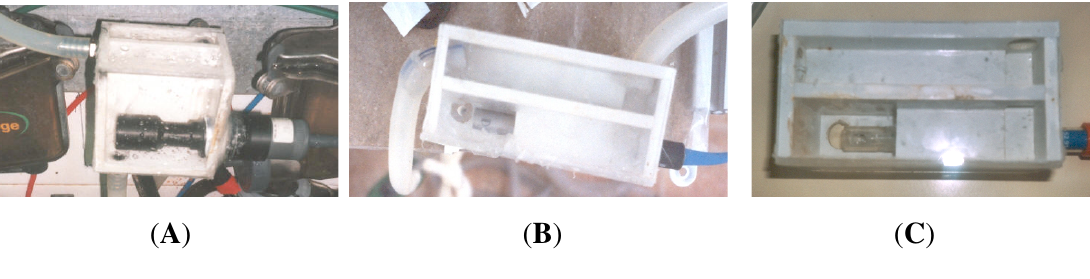
Figure 8. Hand-made boxes for C1 ( A ), C2 ( B ) and C3 ( C )